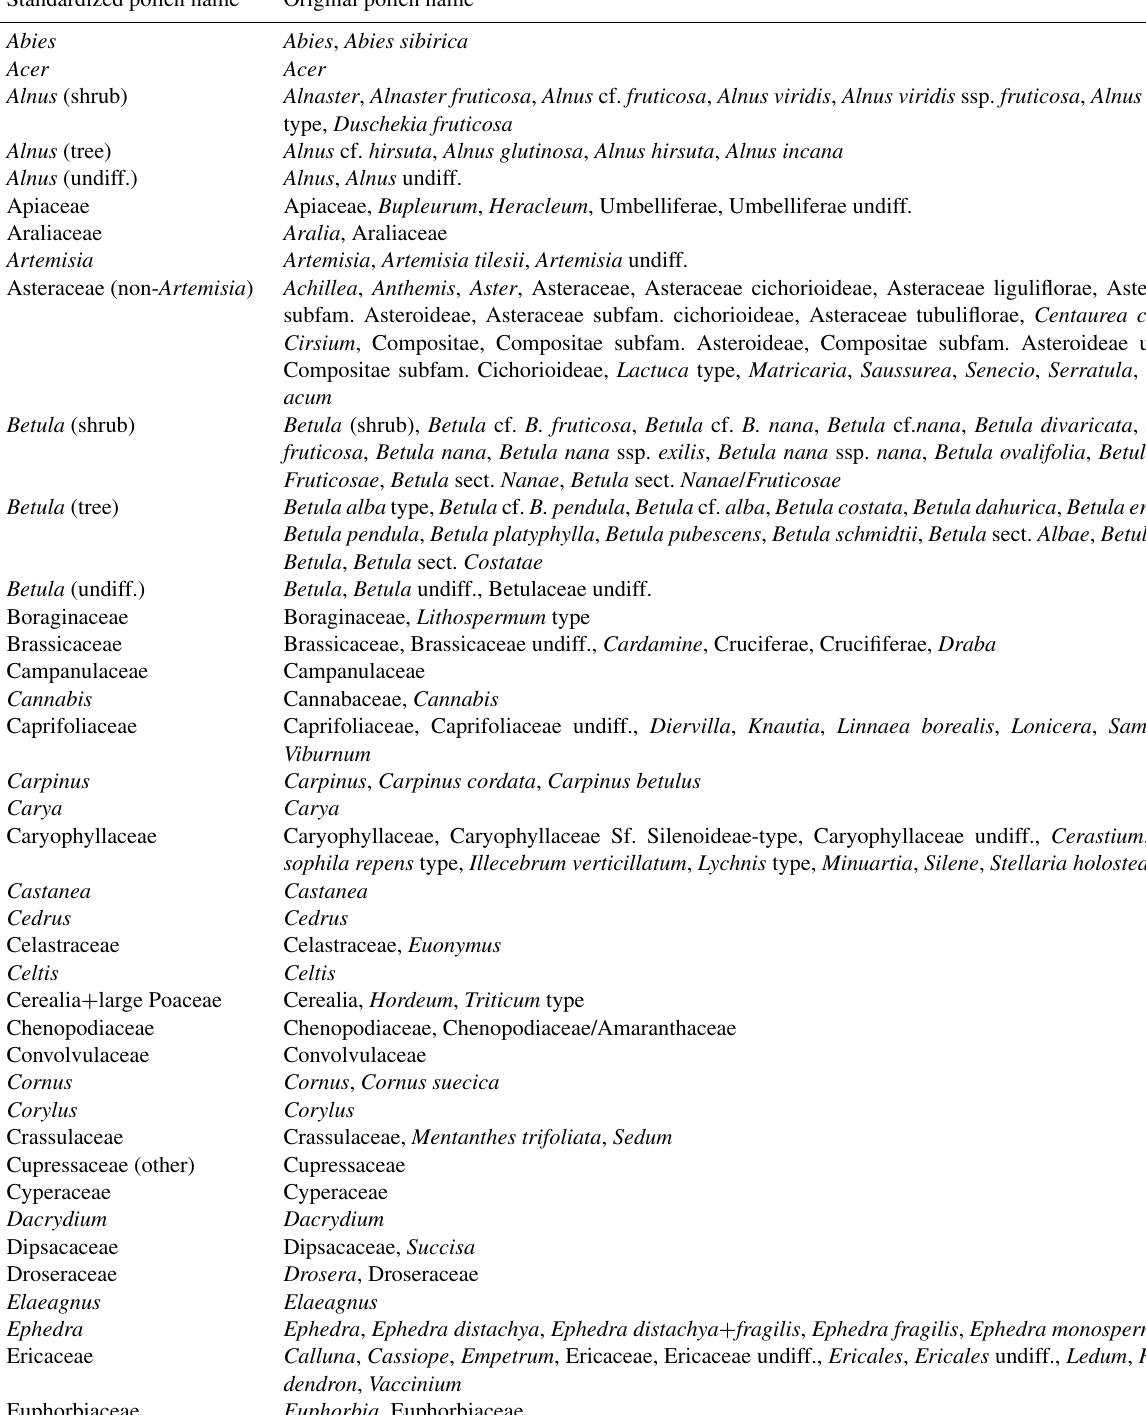
Table B1. Pollen taxa used in the dataset and their corresponding original Latin